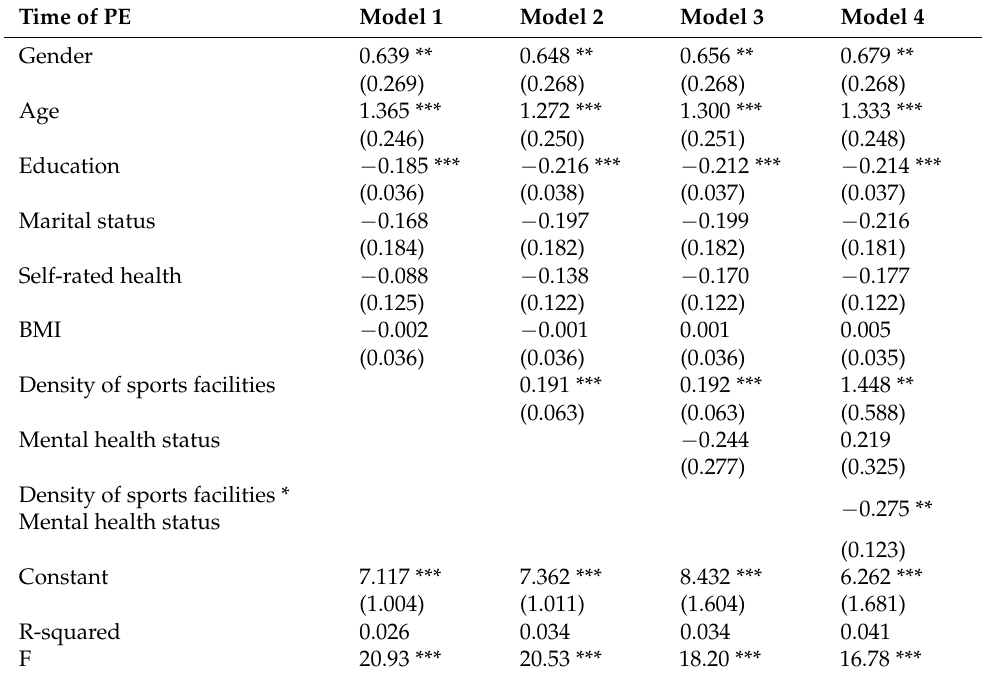
Table 3. Multiple linear regression results for PE time and density of sports facilities and mental health